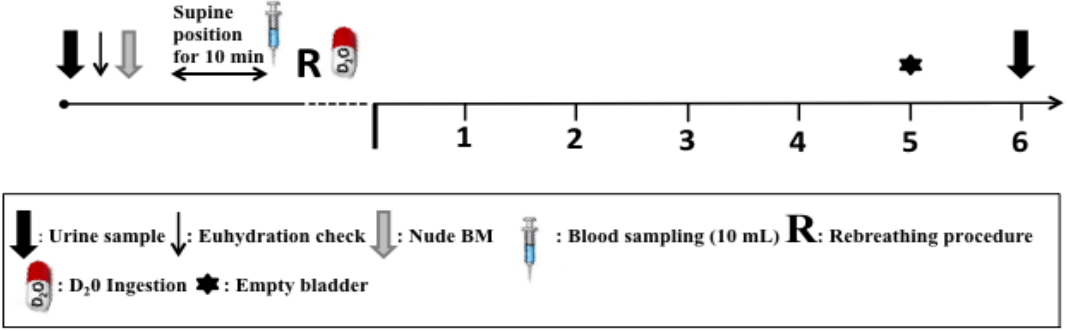
Figure 1. Schematic representation of procedures during experimental